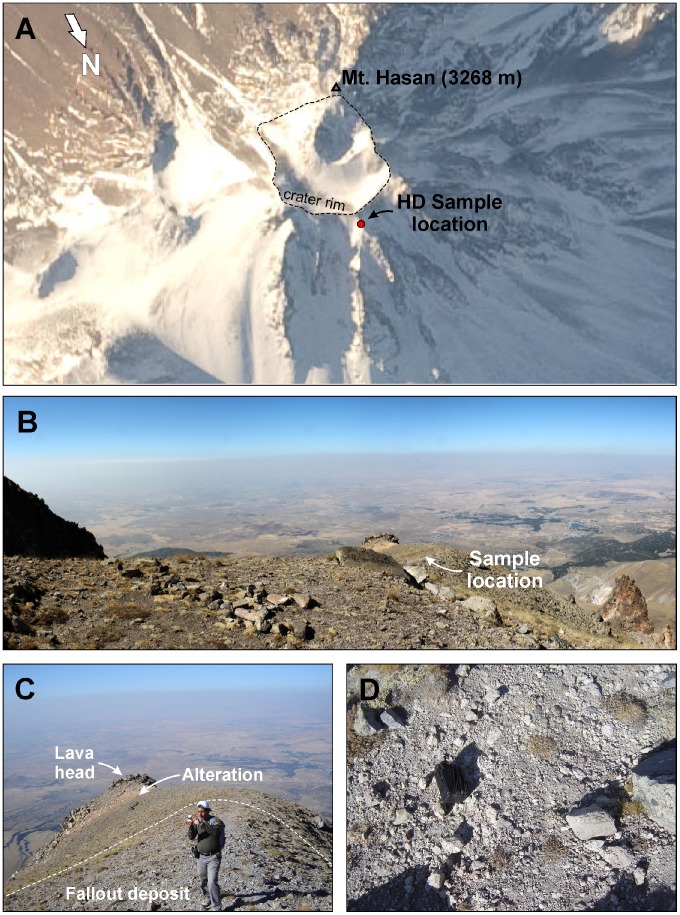
Location and field pictures for andesitic pumice deposit (sample HD) collected near the summit of Hasan Dağı.Astronaut photography of Hasan Dağı summit showing the location of sample HD (red dot) outside the crater rim (A). Image ISS022-E-5307 courtesy of the Image Science & Analysis Laboratory, NASA Johnson Space Center (http://eol.jsc.nasa.gov). Field scene of HD sampling location looking N (B). Light colored fall-out deposit abutting altered lava with geologist for scale (C). Close-up of pumice veneer at HD sampling location with camera pouch (center left) for scale (D).